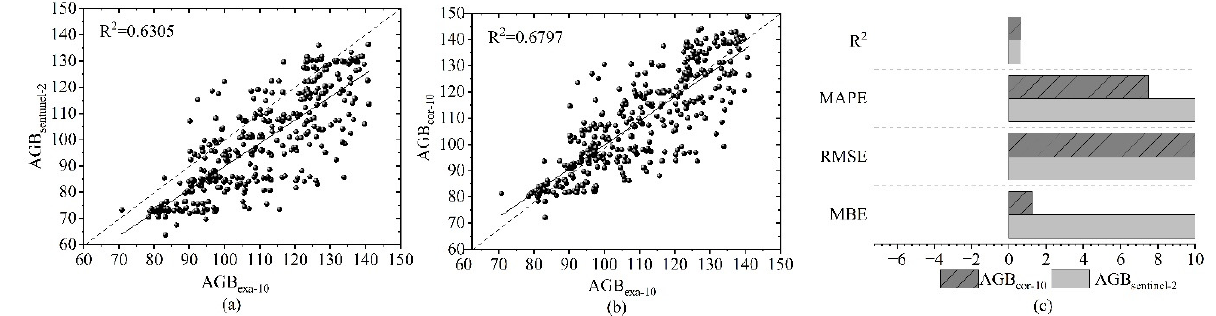
Figure 7. Scatter plot of the pre ‐ and post ‐ correction results and true AGB and the accuracy com ‐ parison of 10 m. ( a ) Scatter plot of the pre ‐ correction results and true AGB at 10 m; ( b ) scatter plot of the post ‐ correction results and true AGB at 10 m; ( c ) accuracy comparison.